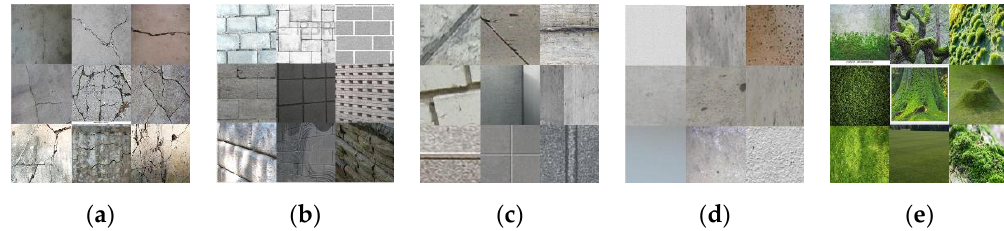
Figure 4. Examples of detailed categorization of images for crack detection: ( a ) Crack; ( b ) Joint/Edge (ML); ( c ) Joint/Edge (SL); ( d ) Intact Surface; and ( e ) Plant.